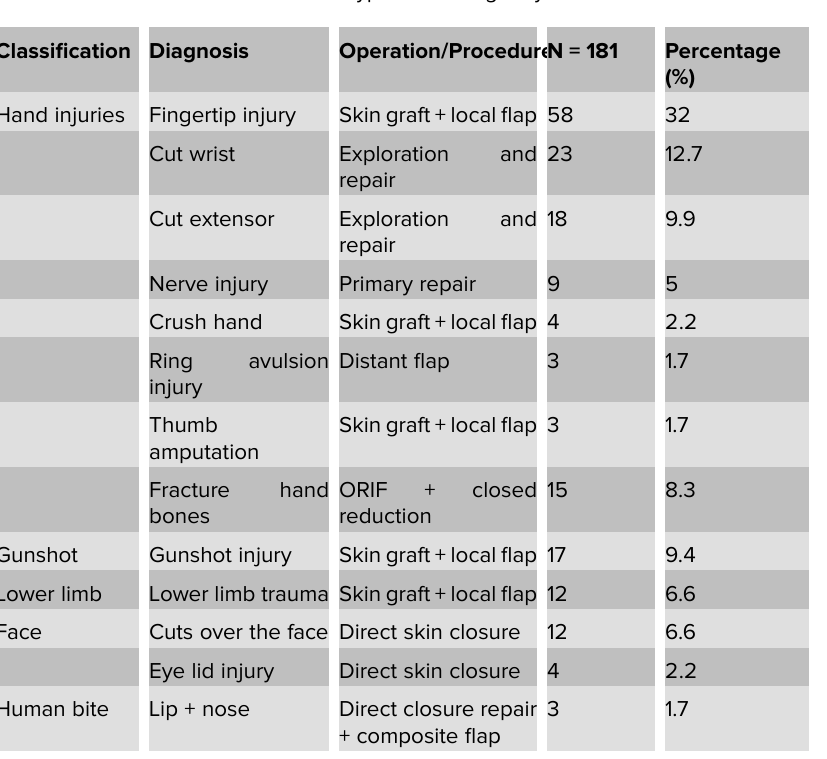
Figure 7 : Breast canser reconstruction. Table 1: Types of emergency reconstructive